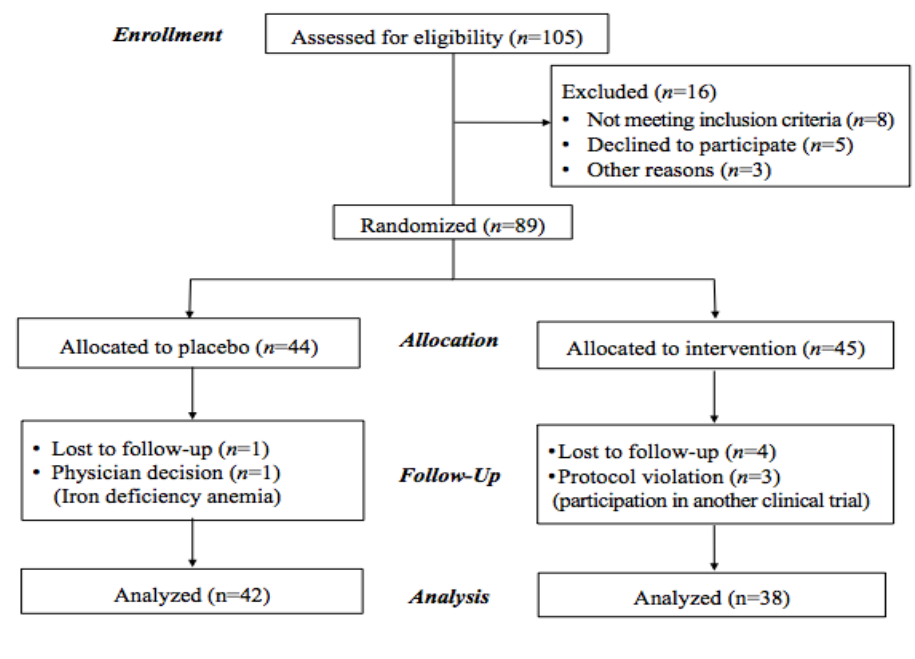
Figure 1. Flow diagram of the progress through the phases of a randomized